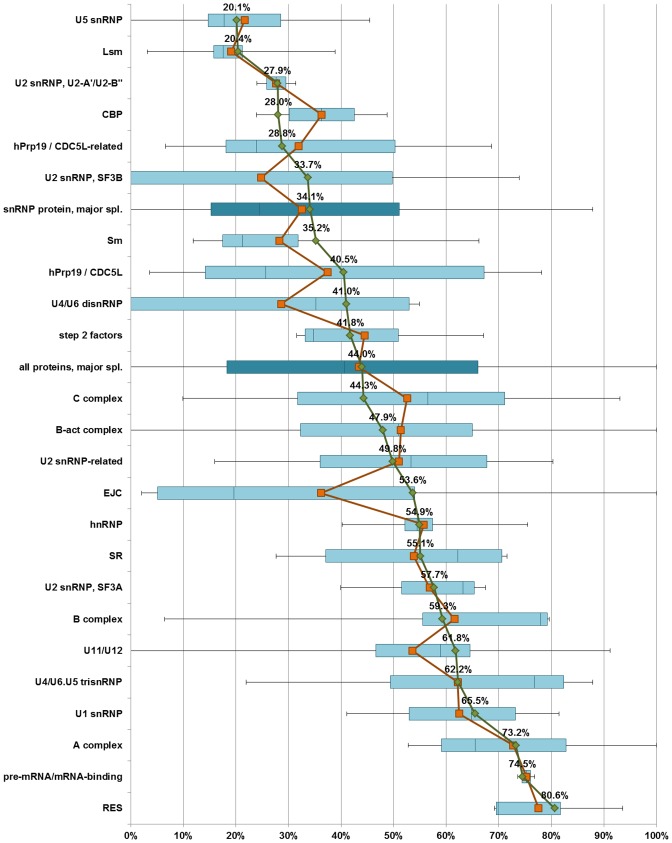
Intrinsic disorder content of the various groups of core spliceosome proteins.In deeper shades are marked the values for all proteins of the snRNP subunits of the major spliceosome (“snRNP proteins, major spl.”) and for all the proteins of the major spliceosome (“all proteins, major spl.”). The orange line indicates means calculated per-protein (disorder fraction was calculated for each protein first, and then a mean was taken out of this) while the green line indicates means calculated per-residue (the number of all disordered residues in a protein group divided by the total length of proteins in the group). Per-residue means are indicated above the line. Spliceosome protein groups are ordered according to per-residue means.